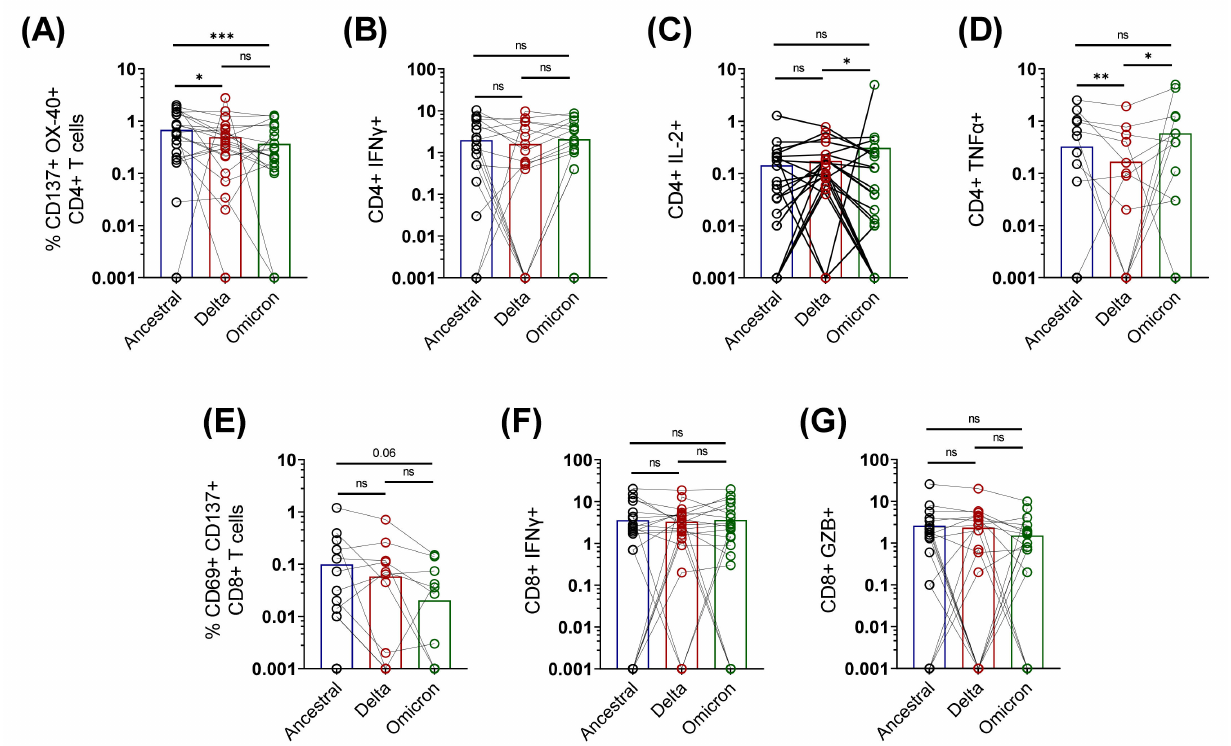
Figure 3. Cross-reactive CD4+ and CD8+ T cell response against delta and omicron spike in acute COVID-19 patients; spike-specific T cell responses in selected samples of active COVID-19 patients (n = 24) were simultaneously tested for reactivity against spike peptide pools of ancestral, delta, (B.1.617.2), and omicron (B.1.1.529). ( A – D ) Frequencies of antigen-specific CD4+ T cell responses: ( A ) CD4+ AIM (CD137 + OX40+); ( B ) CD4+ IFN γ ; ( C ) CD4+ IL2; ( D ) CD4+ TNF α . ( E – G ) Frequencies of antigen-specific CD8+ T cell responses: ( E ) CD8+ AIM (CD137 + CD69+); ( F ) CD8+ IFN γ ; ( G ) CD8+ granzyme B. Bars represent median values with IQR, each dot represents an individual sample, and the solid line connects the same sample stimulated with different peptide pools. Two-sided Wilcoxon signed rank tests were employed for paired non-parametric analysis. AIM, activation-induced markers; GZB, granzyme B; ns not significant * p < 0.05, ** p ≤ 0.01, *** p <